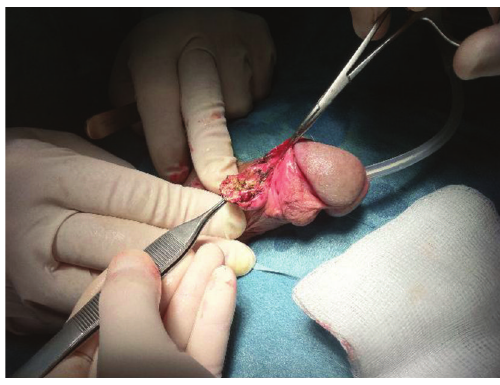
Figure 1: Surgical excision of the tophi in the penis.